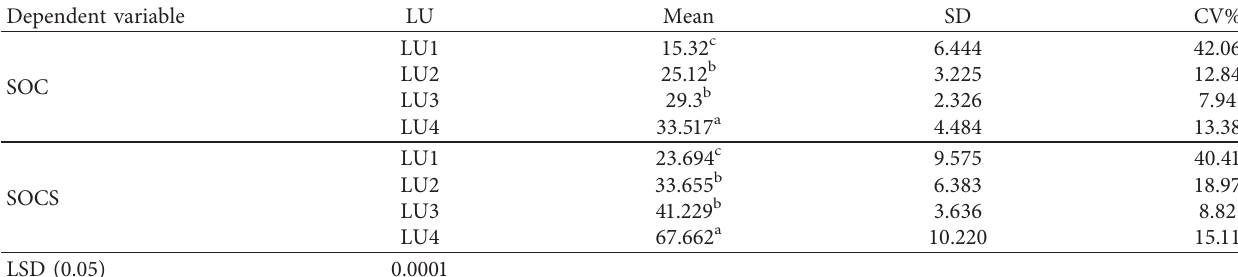
Table 3: The mean differences of soil organic carbon at different land use types in the study area. Dependent